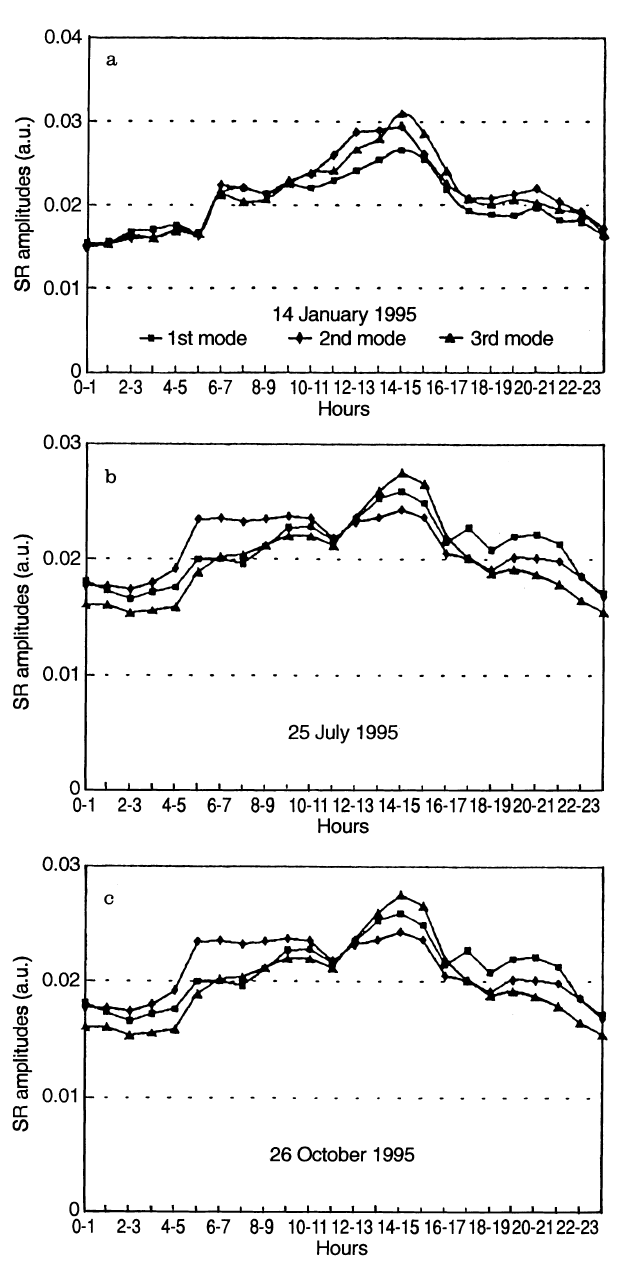
Fig. 7a–c. Diurnal variation of the SR amplitudes (in three modes) on the same days as for the PG in Fig. 6: a winter day, b summer day, c autumn day